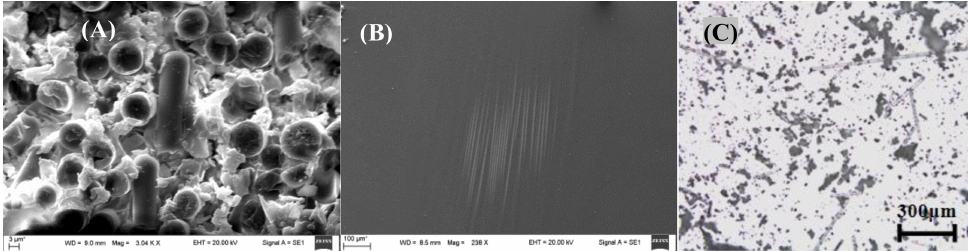
Figure 2. ( A ) SEM micrograph of the fracture cross-section, ( B ) SEM image of the surface of the fabricated GFRC laminates, and ( C ) Metallographic image of the milled GFRC sample.